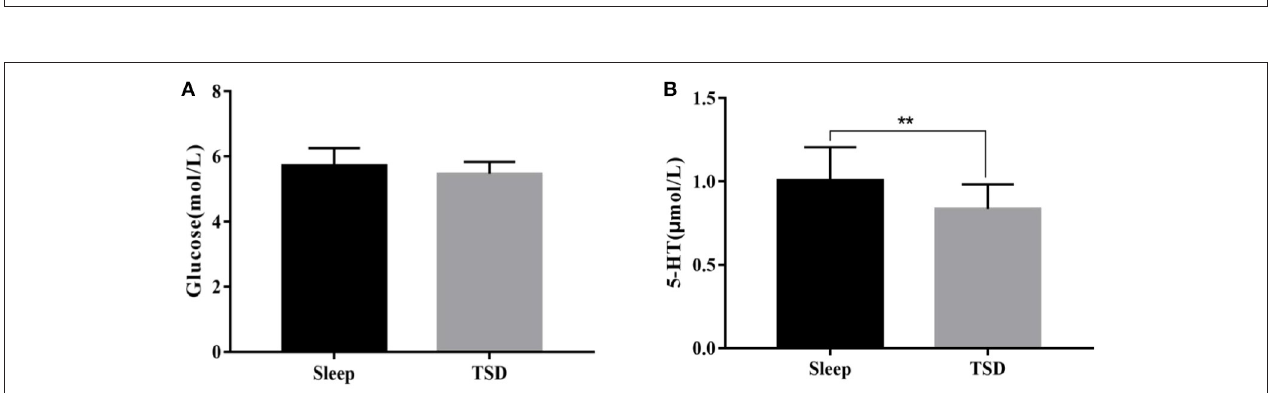
FIGURE 3 | Comparison of fasting blood glucose and 5-ht content changes under sleep deprivation and normal sleep conditions. (A) Change in the content of glucose and (B) Change in the content of 5-HT. ** p < 0.01.